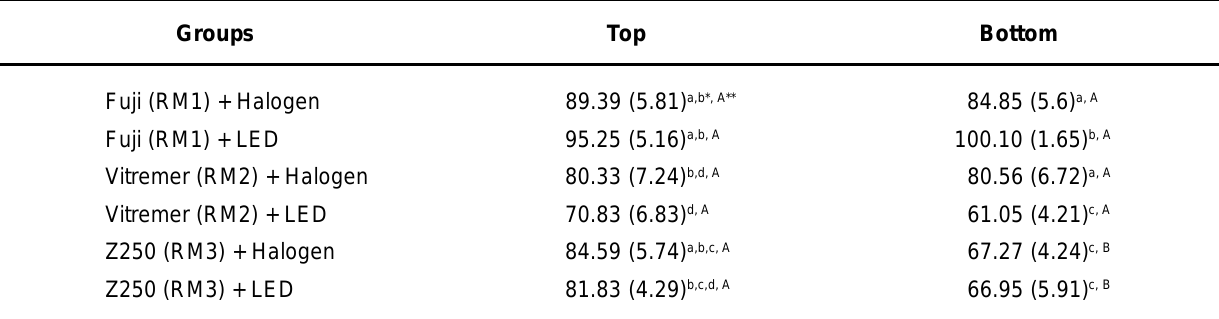
*similar lower case letters in each column indicate no statistically significant difference between groups. **similar upper case letters in each line indicate no statistically significant difference between